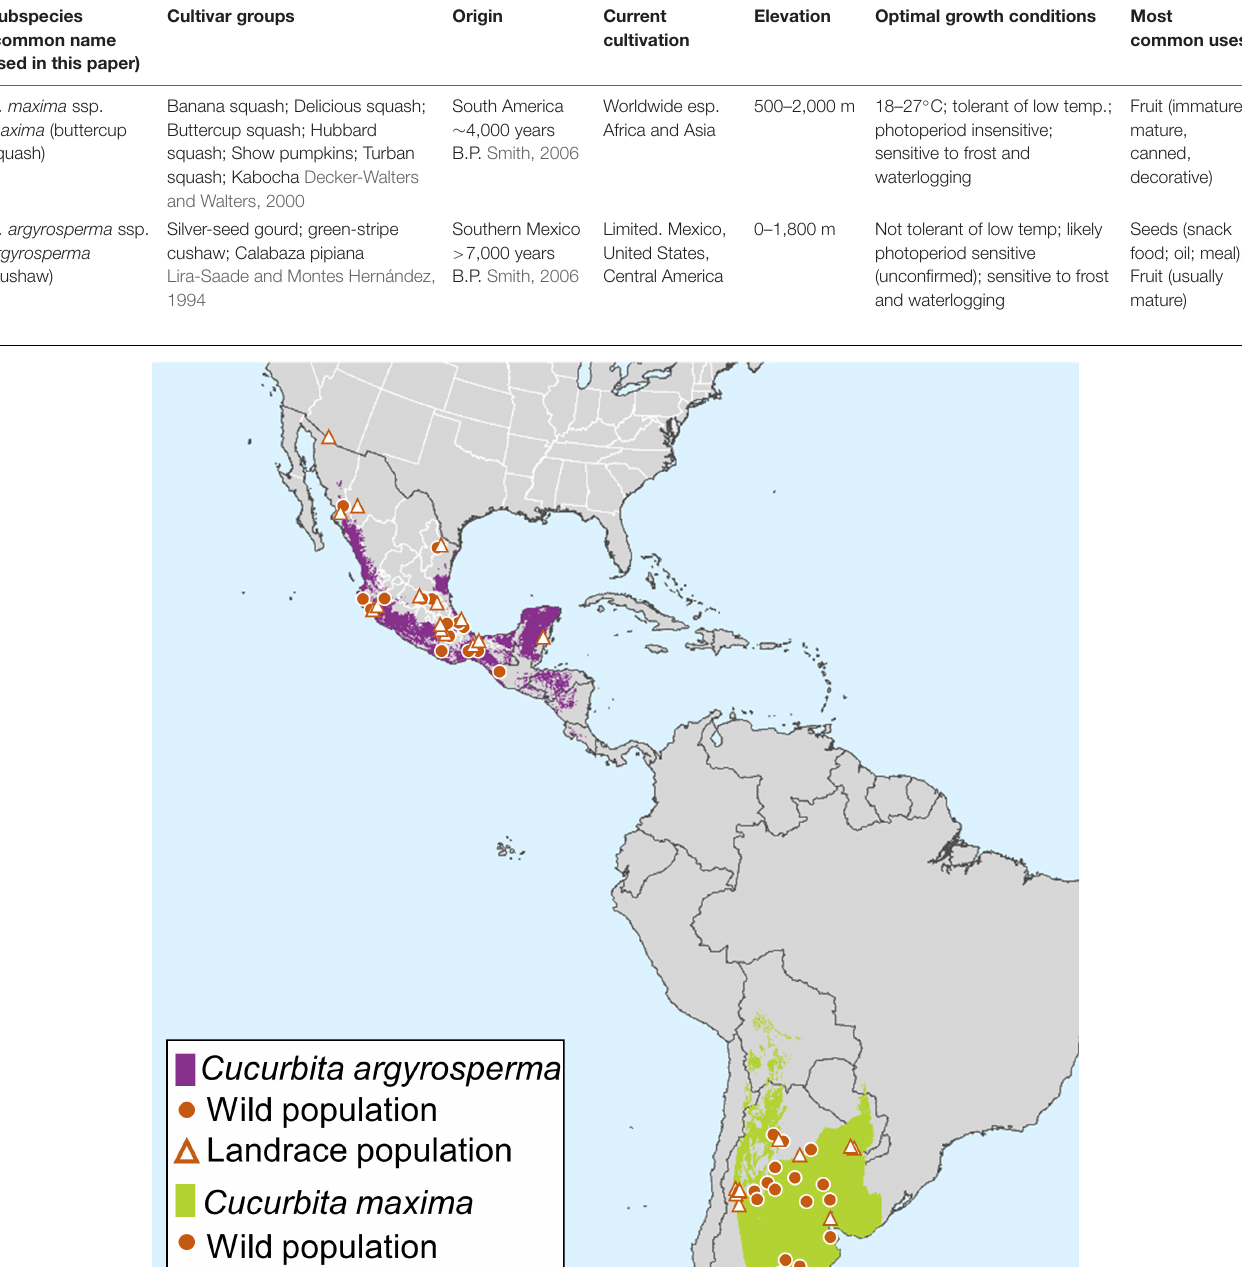
TABLE 1 | Summary information about each domesticated subspecies.